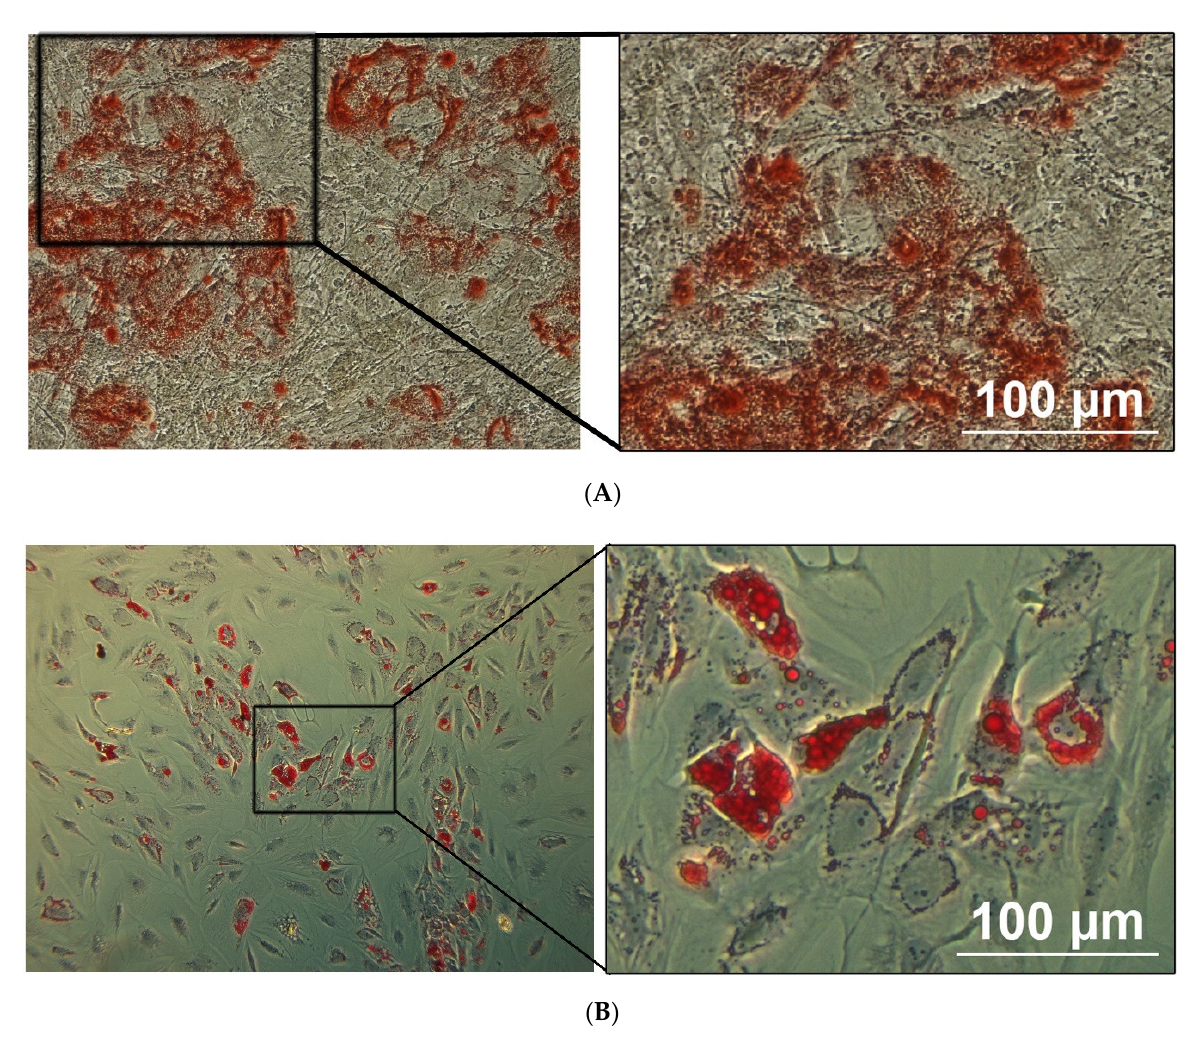
Figure 3. The differentiation potential of adipose MSCs is confirmed by light microscopy. The osteogenic and adipogenic differentiation of MSCs are carried out in specific induction media and confirmed by using lineage-staining techniques. The images are representative for MSCs differentiated into osteoblast ( A ) and adipocytes ( B ), being confirmed by using Alizarin Red (calcium deposits) and Oil red O (Lipid vacuoles) staining, respectively. Scale bar = 100 µm.